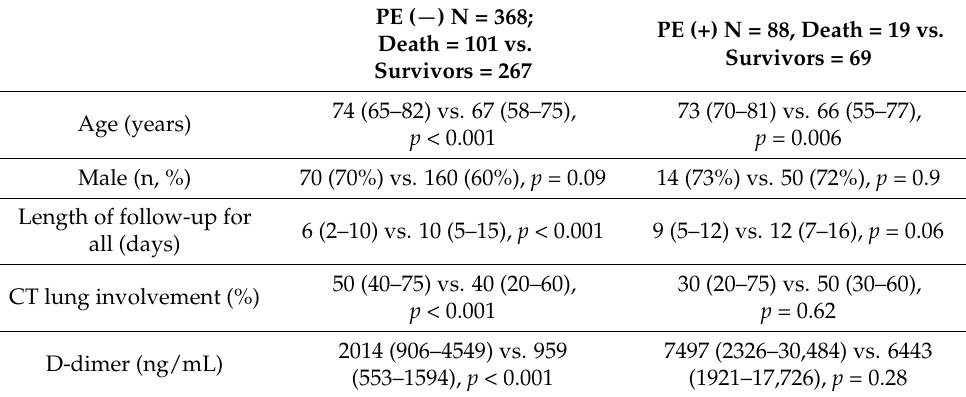
Table 2. Comparison for mortality depending on PE status. Data are presented as number (median, percentage) followed by interquartile range, where applicable. p -values are presented after a comma. PE ( − ) N = 368; Death = 101